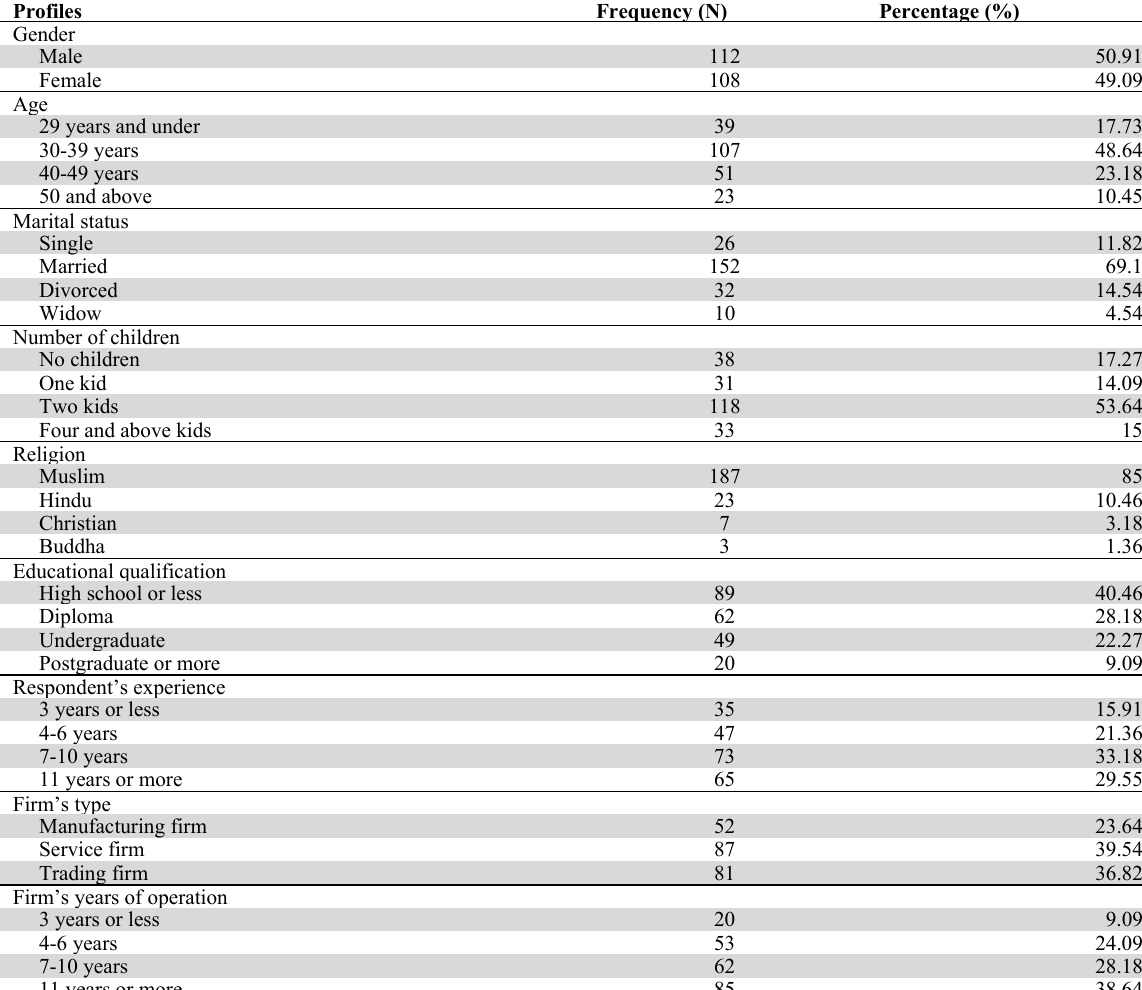
Respondent’s Profile